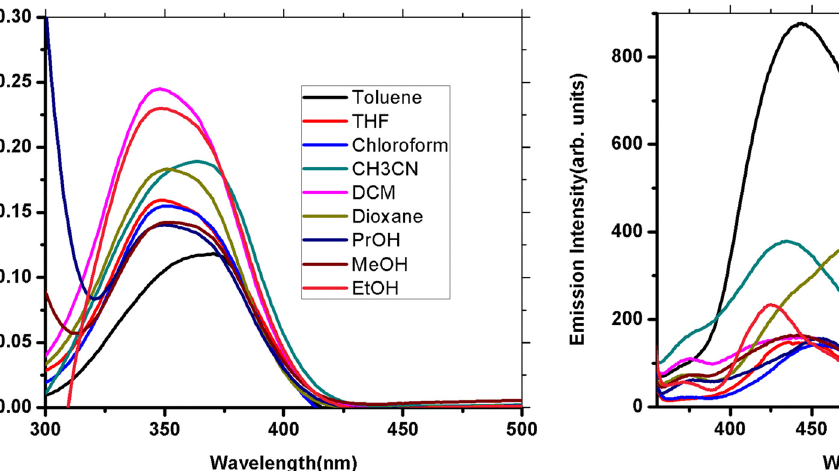
Figure 2: Emission spectra of 1 × 10 − 5 mol L − 1 of DTTP in di ff erent solvents ( λ ex = 365 nm )